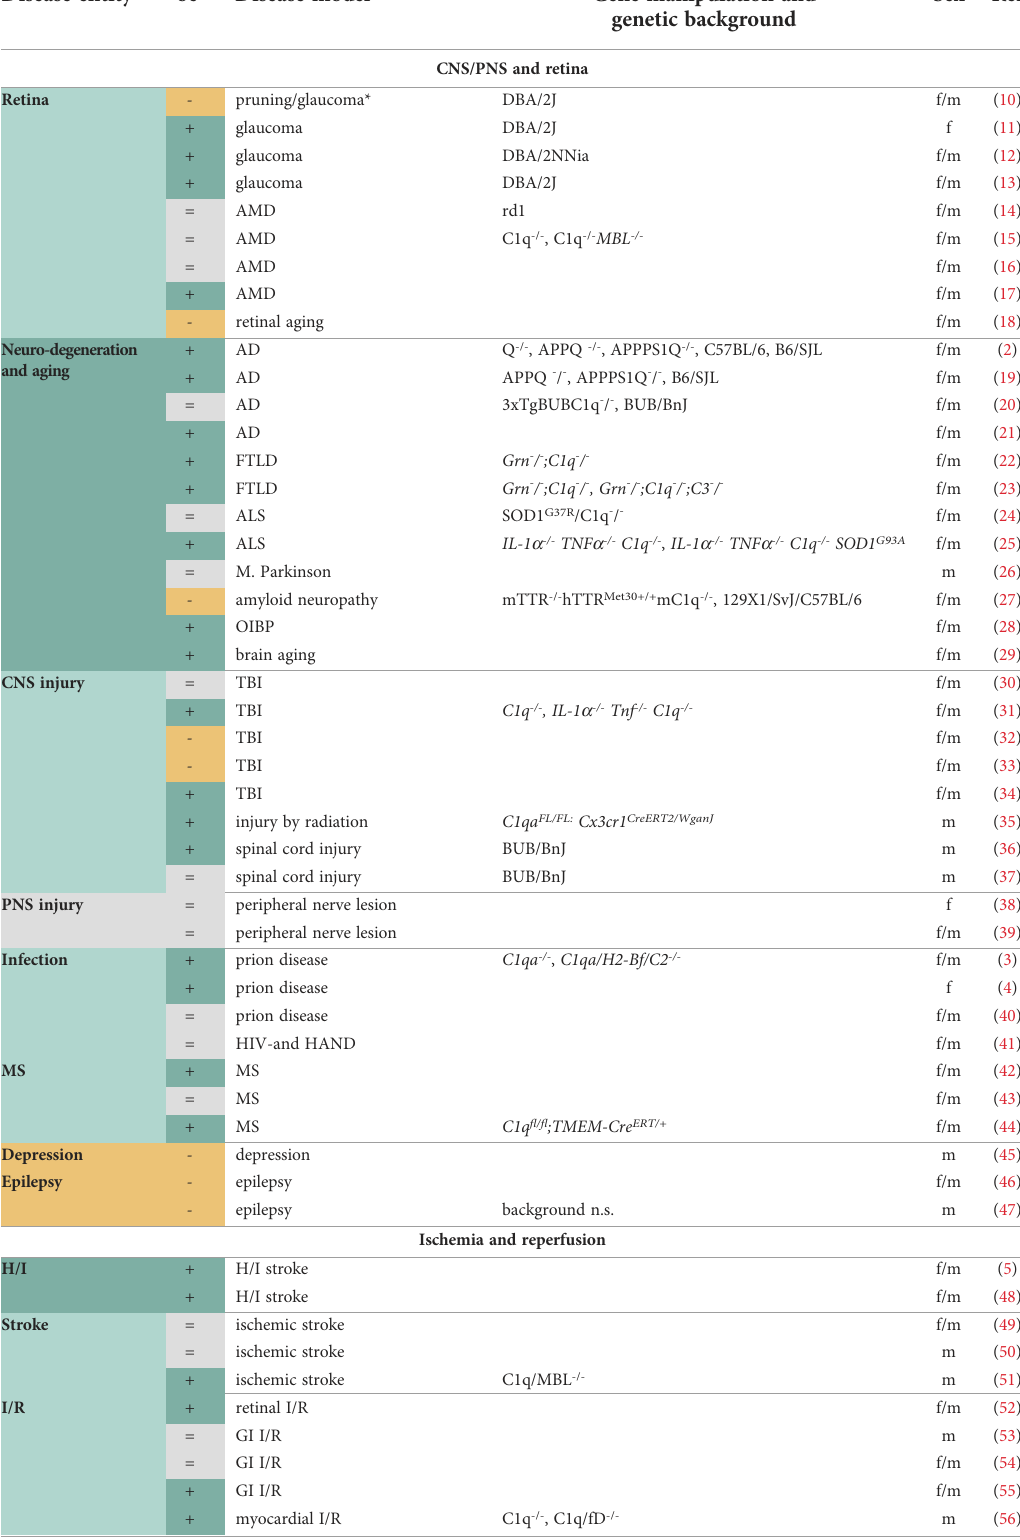
TABLE 1 Overview of publications in the disease clusters CNS/PNS and retina, Ischemia and reperfusion and Liver diseases. Disease entity oc Disease model Gene manipulation and